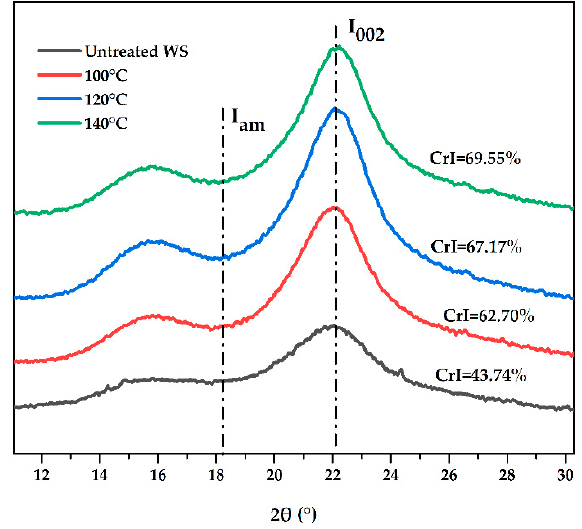
Figure 8. XRD patterns of untreated and treated WS by DES at different pretreatment temperatures.